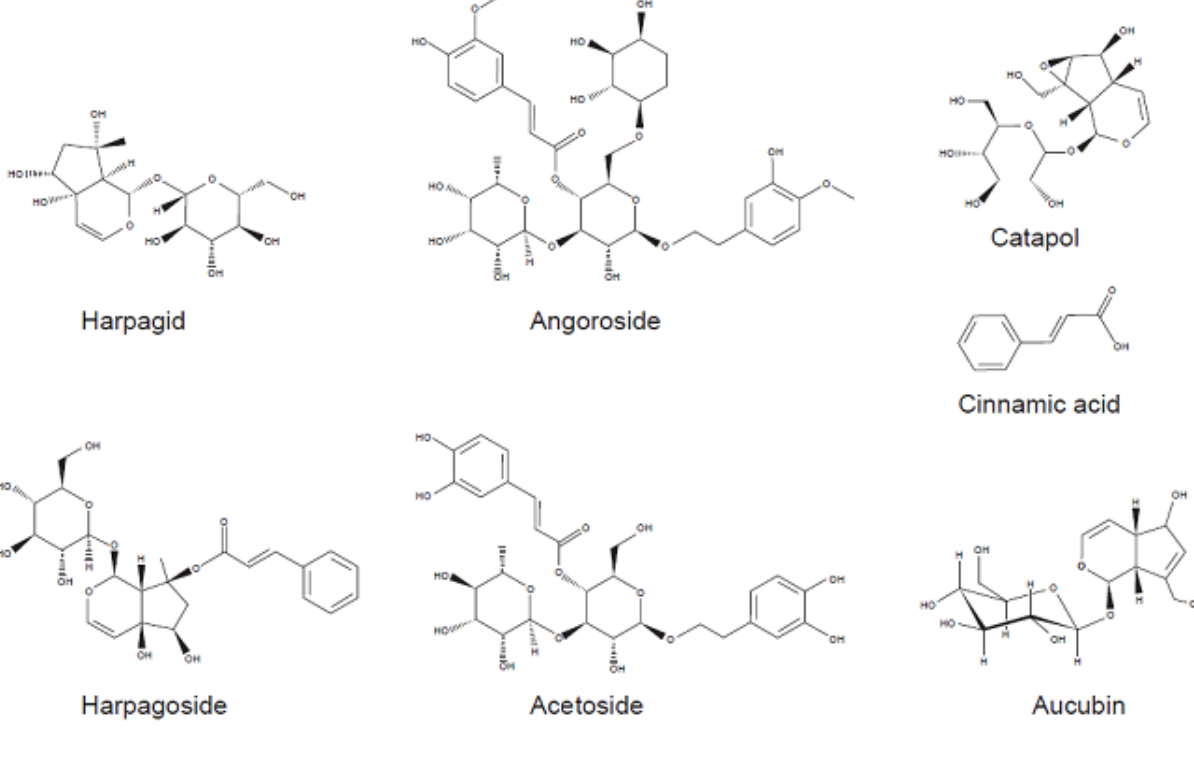
Figure 1. Chemical structures of phytochemicals from Scrophularia ningpoensis